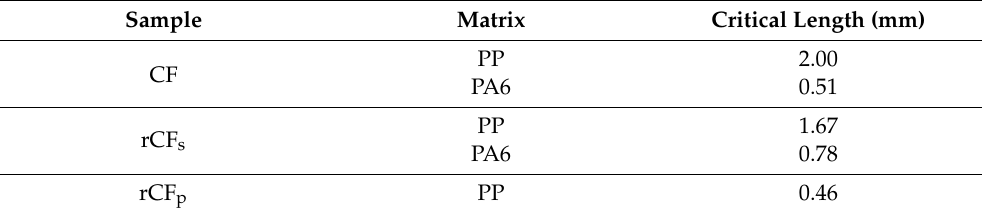
Table 3. Comparison of the critical length of un-sized CF, rCF s , and rCF p in both PP and PA6 matrices. Sample Matrix Critical Length (mm) CF